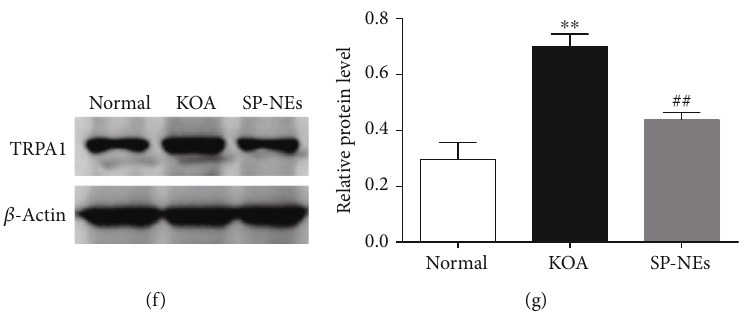
Figure 4: SP-NEs reduce synovitis and TRPA1 expression in vivo. (a). Representative synovial tissues of each group stained with HE, Masson, and Sirius Red staining, × 200, scalebar = 200 μ m . Disorderly arranged synovial lining cells, in fl ammatory cell in fi ltration (red arrow on HE staining), and increased collagen deposition (blue area in the Masson staining) especially collagen type I (bright yellow area in Sirius Red staining, and the green area represented collagen type III) could be observed in the KOA group. (b). Relative gene expression of IL-1 β and IL-18 in synovial tissues of rats in each group. ∗∗ P < 0 : 01 vs. the normal, # P < 0 : 05 , ## P < 0 : 01 vs. the KOA. (c). Typical protein bands of IL-1 β and IL-18 for each group. (d). Relative protein level of IL-1 β and IL-18 in synovial tissues. ∗∗ P < 0 : 01 vs. the normal, ## P < 0 : 01 vs. the KOA. (e). Relative gene expression of TRPA1 in synovial tissues of rats in each group. ∗∗ P < 0 : 01 vs. the normal, ## P < 0 : 01 vs. the KOA. (f). Typical protein bands of TRPA1 (g). Relative protein level of TRPA1 in synovial tissues. ∗∗ P < 0 : 01 vs. the normal, ## P < 0 : 01 vs. the